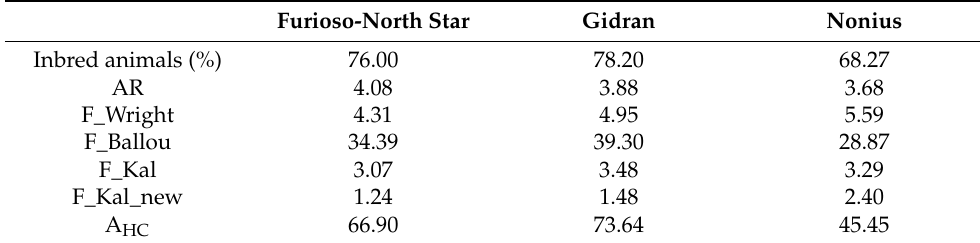
Table 6. Inbreeding in the reference populations.